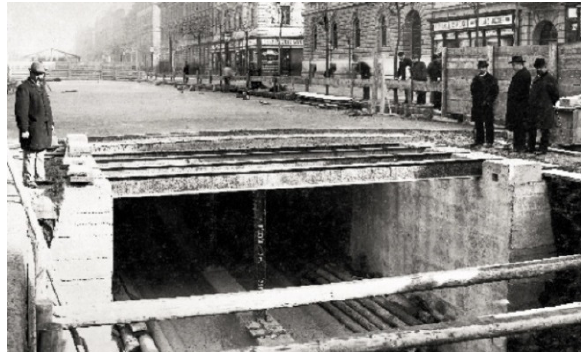
Figure 5. Földalatti under Andrassy Avenue [6]